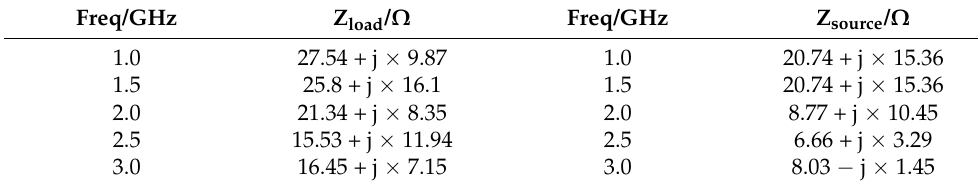
Table 1. The optimal impedance at different frequency